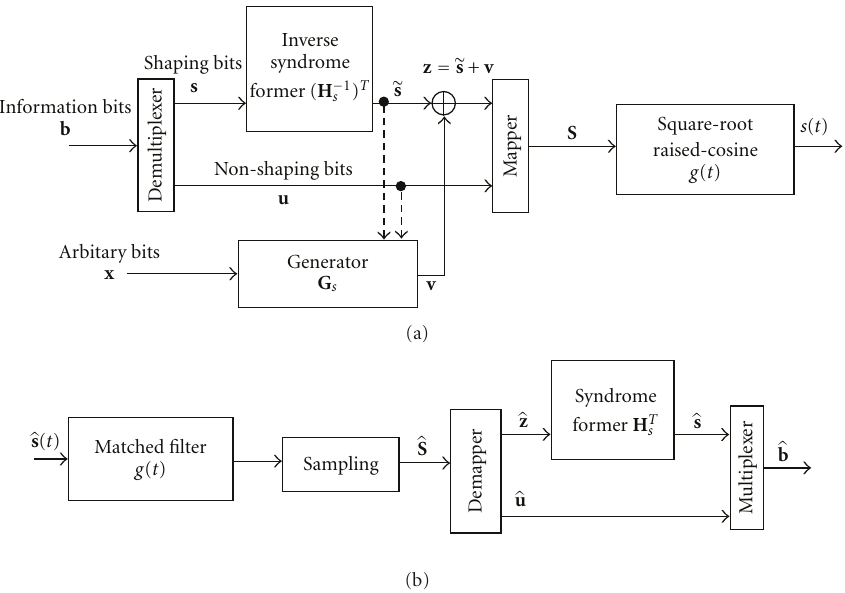
Figure 1: General trellis shaping system model. (a) Transmitter. (b) Receiver.